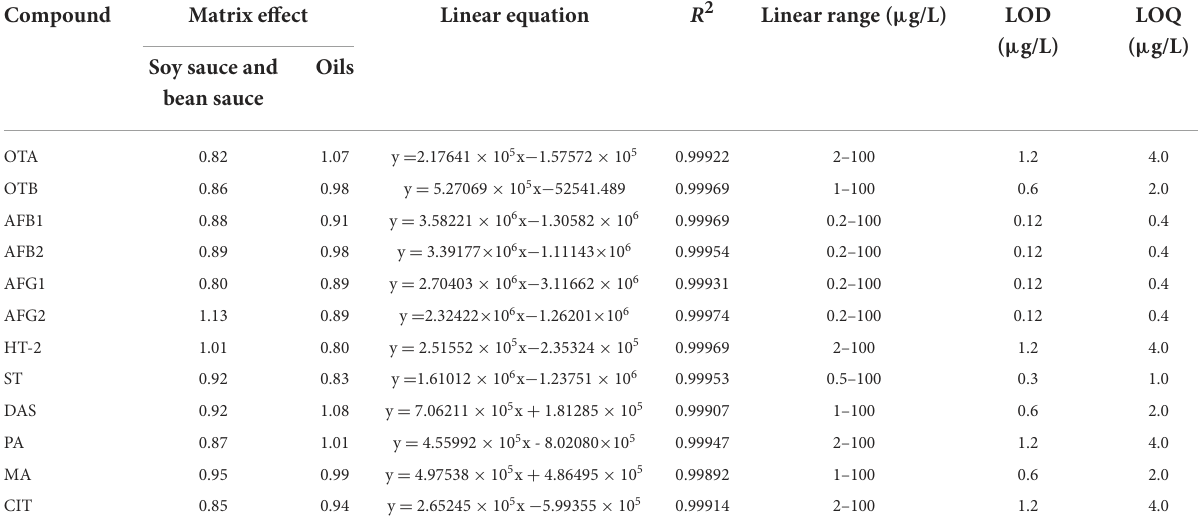
TABLE 3 Matrix effect, linear ranges, regression equations, determination coefficients, LODs, and LOQs for 12 mycotoxins. Compound